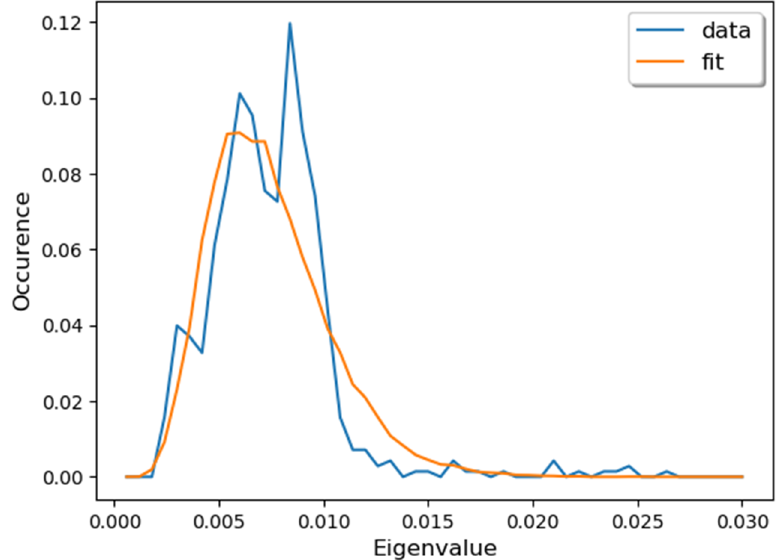
Figure 12. Statistical-model-fitting-generalised gamma distribution over clean pixels used in Potpecko Lake clean mask.